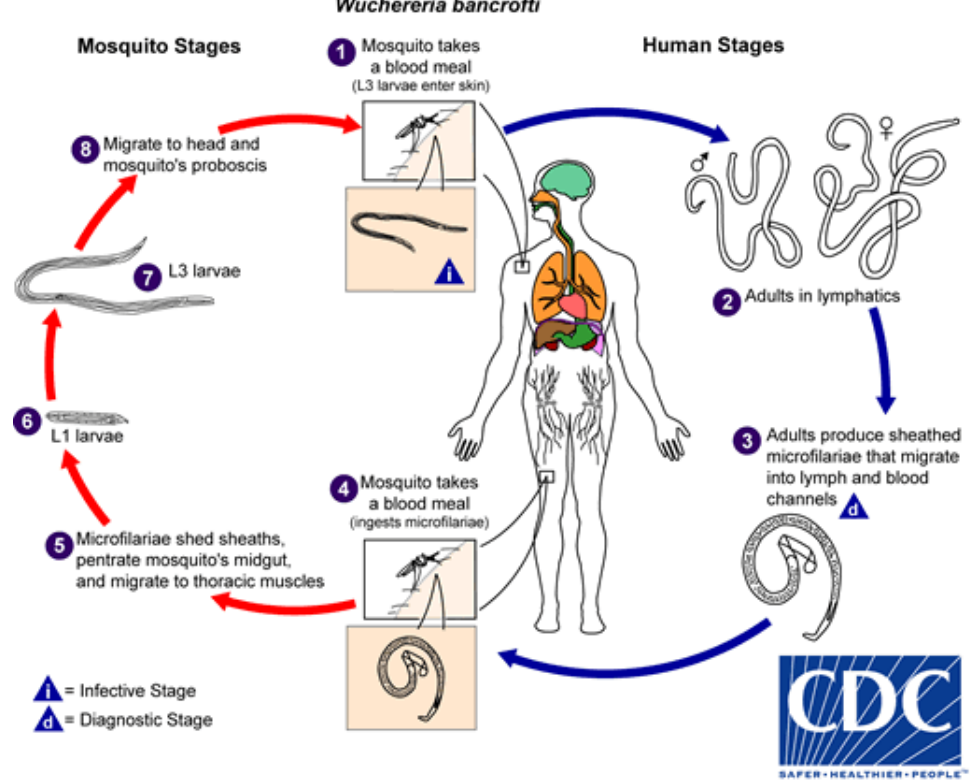
Figure 3. Life cycle of Wuchereria bancrofti. Image courtesy of the Centers for Disease Control and Prevention [14].